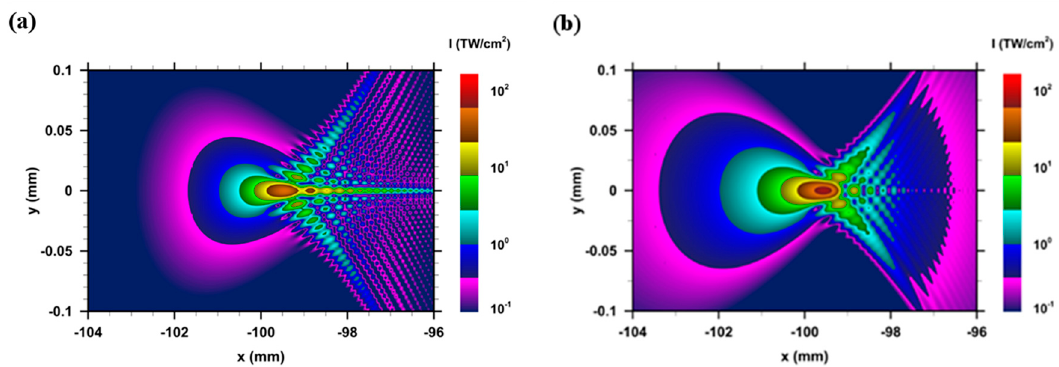
Figure 1. Spatial distribution of ( a ) f/5, and ( b ) f/10, 1064-nm focusing with the Thorlabs LA4545, 100-mm focal length lens [15].